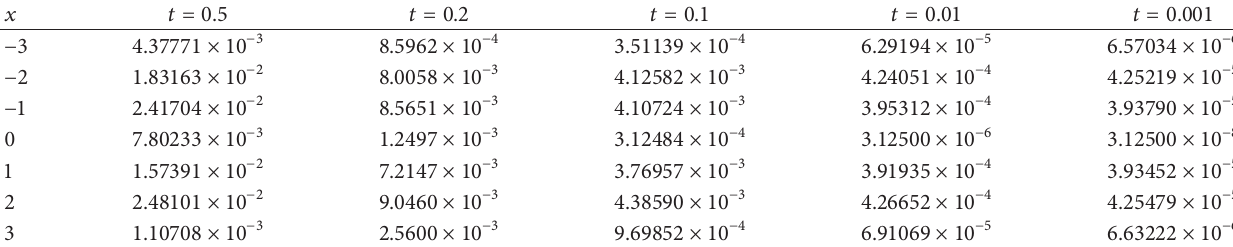
Table 1: Absolute error of OHAM solution 𝛽(𝑥,𝑡) corresponding to the exact solution.